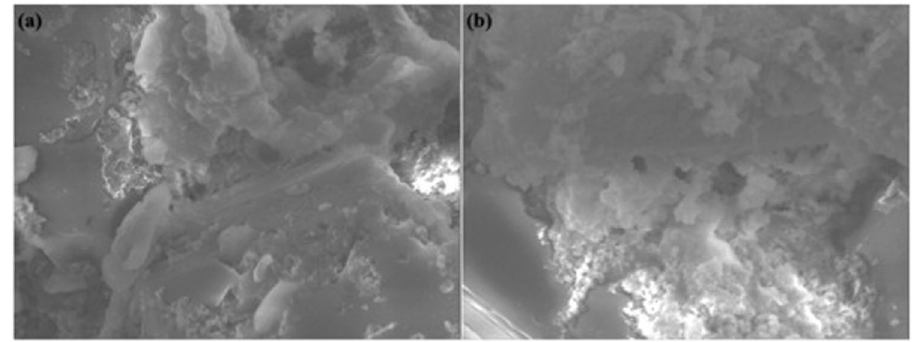
Figure 1. Electron microscope images of the solid precipitate collected at the end of the incubation period of sludge dewatering liquors without pH control at 2000 × magnification: ( a ) B. antiquum ; ( b ) non-inoculated